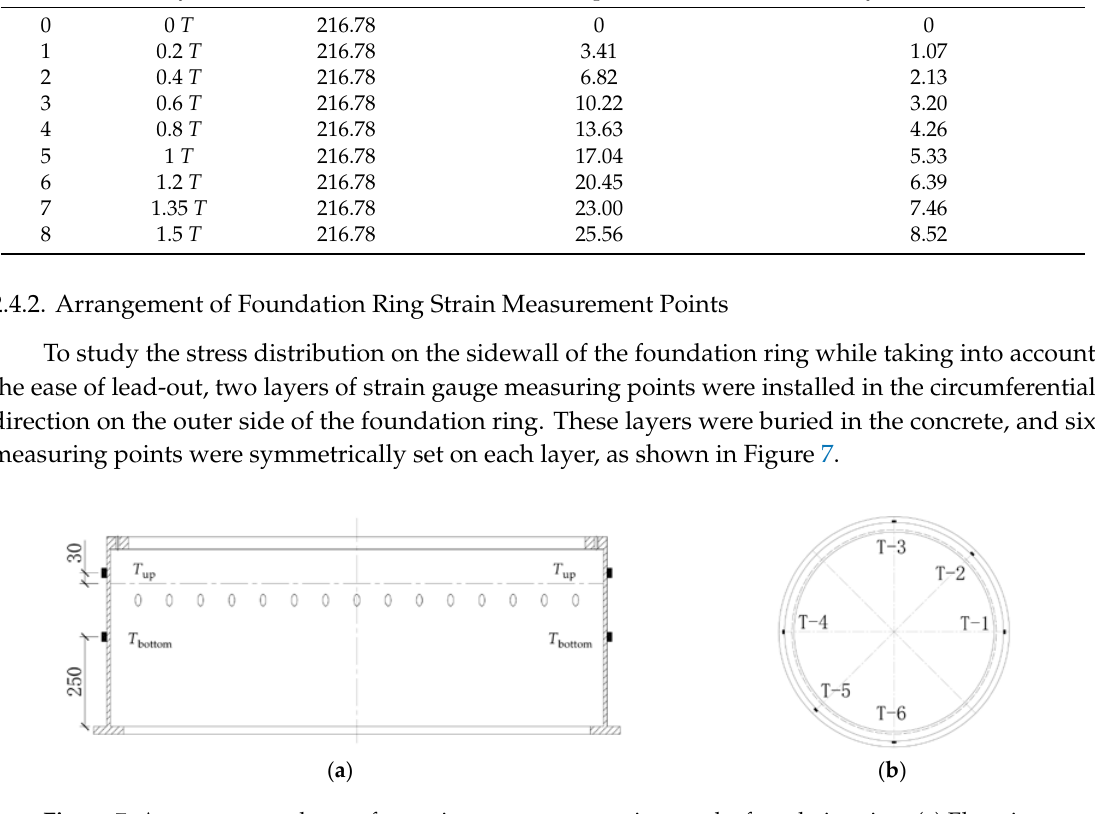
Figure 7. Arrangement schemes for strain measurement points on the foundation ring. ( a ) Elevation view of strain gauge layout ( b ) Top view of strain gauge layout.